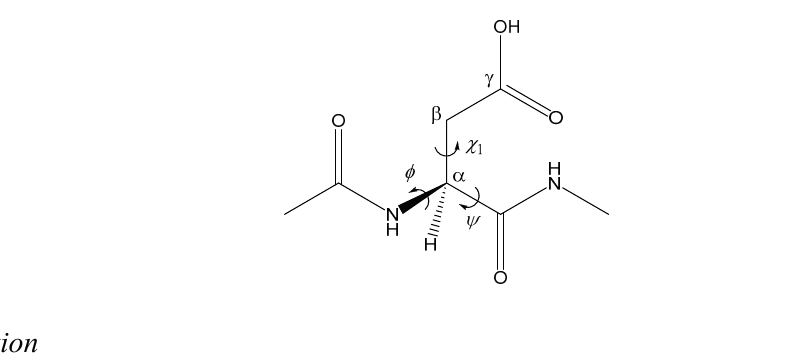
Figure 13. The model compound used in the present study (Ace − Asp − Nme). The φ (C − N − C − C) and ψ (N − C − C − N) dihedral angles which characterize the α α